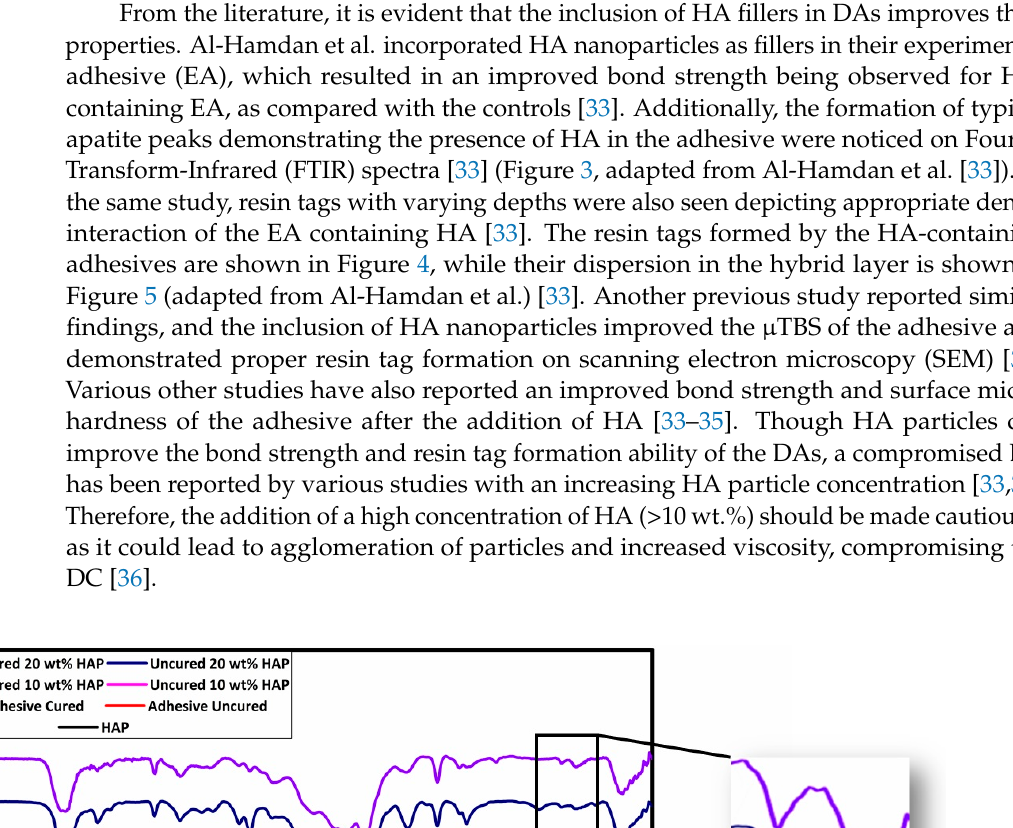
Figure 4. SEM micrograph of HA-containing adhesive demonstrating resin tag formation of varying depths. Reprinted with permission from Al-Hamdan et al. [33]. Copyright 2020 MDPI.